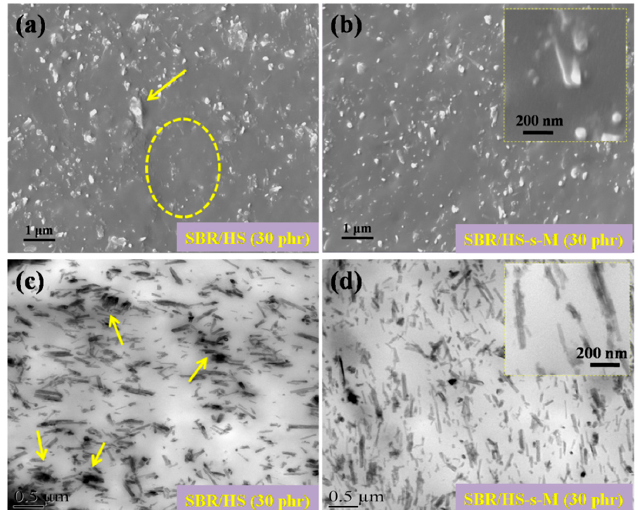
Figure 4. SEM images of SBR / HS ( a ) and SBR / HS-s-M ( b ) composites, TEM images of SBR / HS ( c ) and SBR / HS-s-M ( d ) composites (the insets in ( b ) and ( d ) are higher magnification images of SEM and TEM for SBR / HS-s-M composites, respectively).